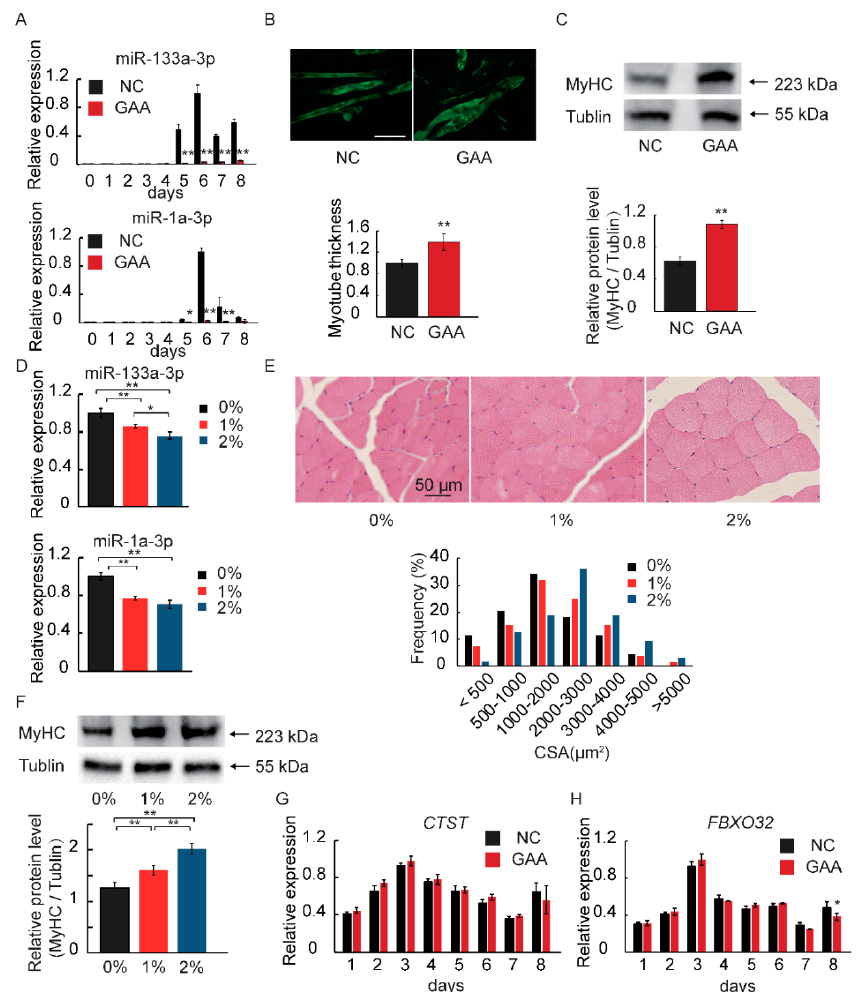
Figure 4. Effect of GAA on myoblasts during muscle growth. ( A ) The expression of miR-133a-3p and miR-1a-3p during myoblast differentiation after GAA treatment (Student’s t -test); ( B ) myotubes were stained with anti-MyHC antibody and the myotube thickness was determined (Student’s t -test); ( C ) MyHC protein levels were calculated by western blotting (Student’s t -test); ( D ) the expression of miR-133a-3p and miR-1a-3p after GAA supplement in mouse gastrocnemius tissue (Tukey’s post-hoc test); ( E ) hematoxylin-eosin staining of gastrocnemius muscle and the quantification of muscle fiber size(CSA: cross-sectional area); ( F ) MyHC protein levels were calculated by western blotting in mouse gastrocnemius tissue (Tukey’s post-hoc test); ( G , H ) the protein degradation marker genes ( CTSL and FBXO32 ) were quantified by real-time PCR (Student’s t -test). Results are expressed as mean ± S.D. of three independent experiments. * p < 0.05; ** p < 0.01 compared with the negative control (on the bars) or between the indicated groups.